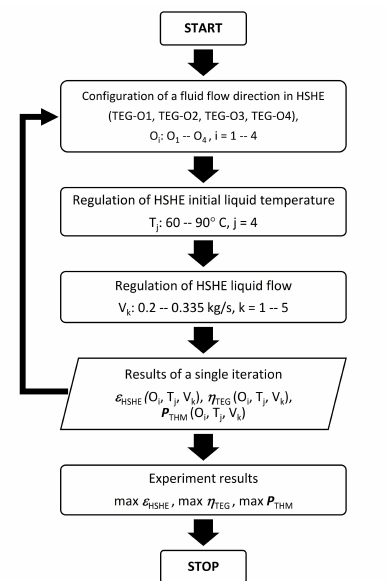
Figure 8. The algorithm of the experiment to analyze the parameters of the MTEG